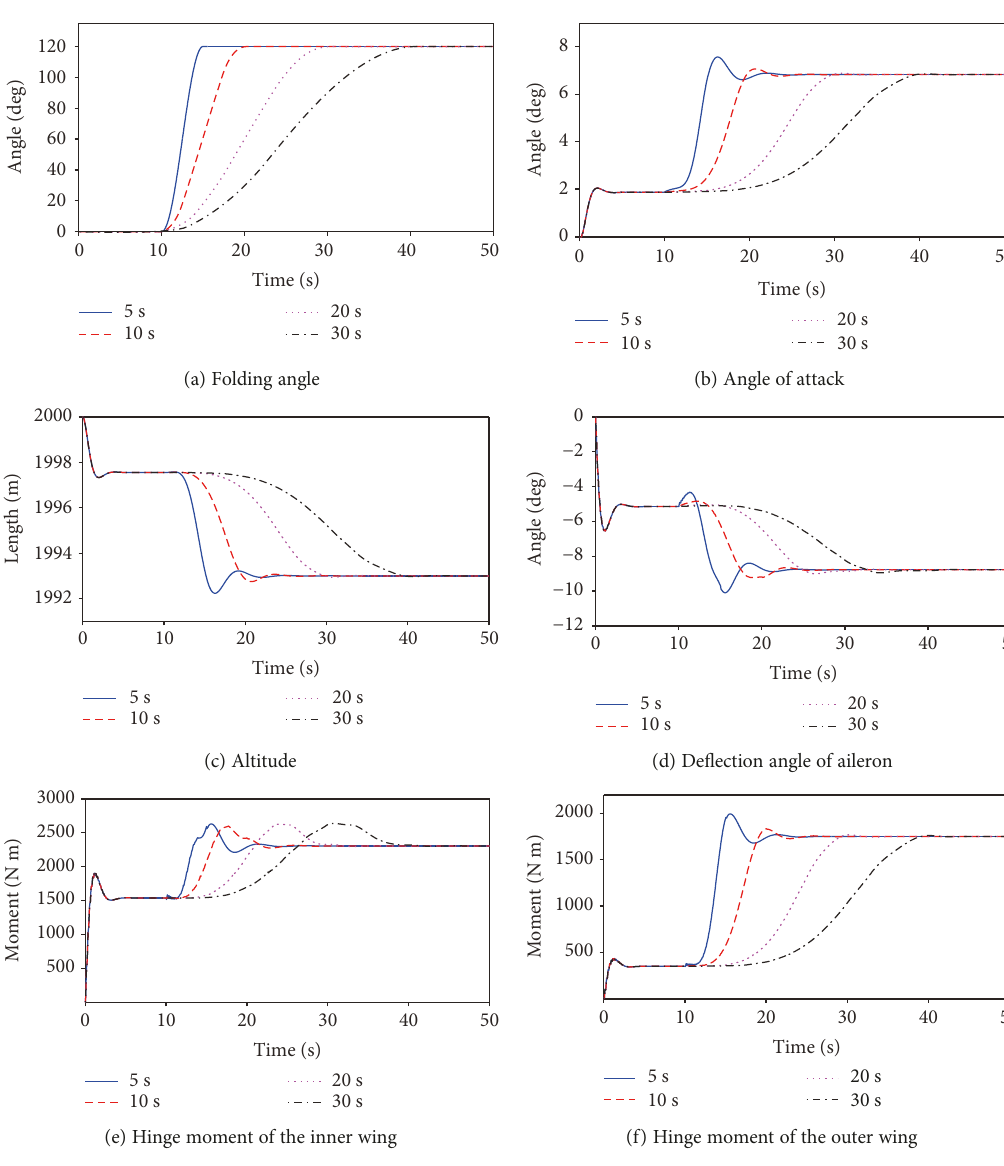
(d) De fl ection angle of aileron